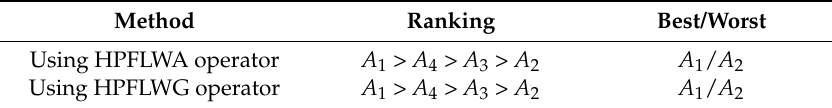
Table 9. Ranking of alternatives using proposed HPFLWA and HPFLWG